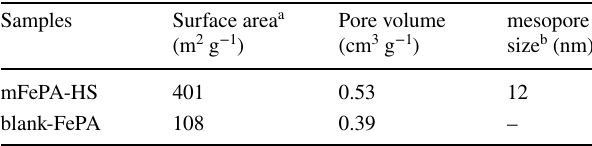
Table 1 Porous properties of the mFePA-HS and blank-FePA